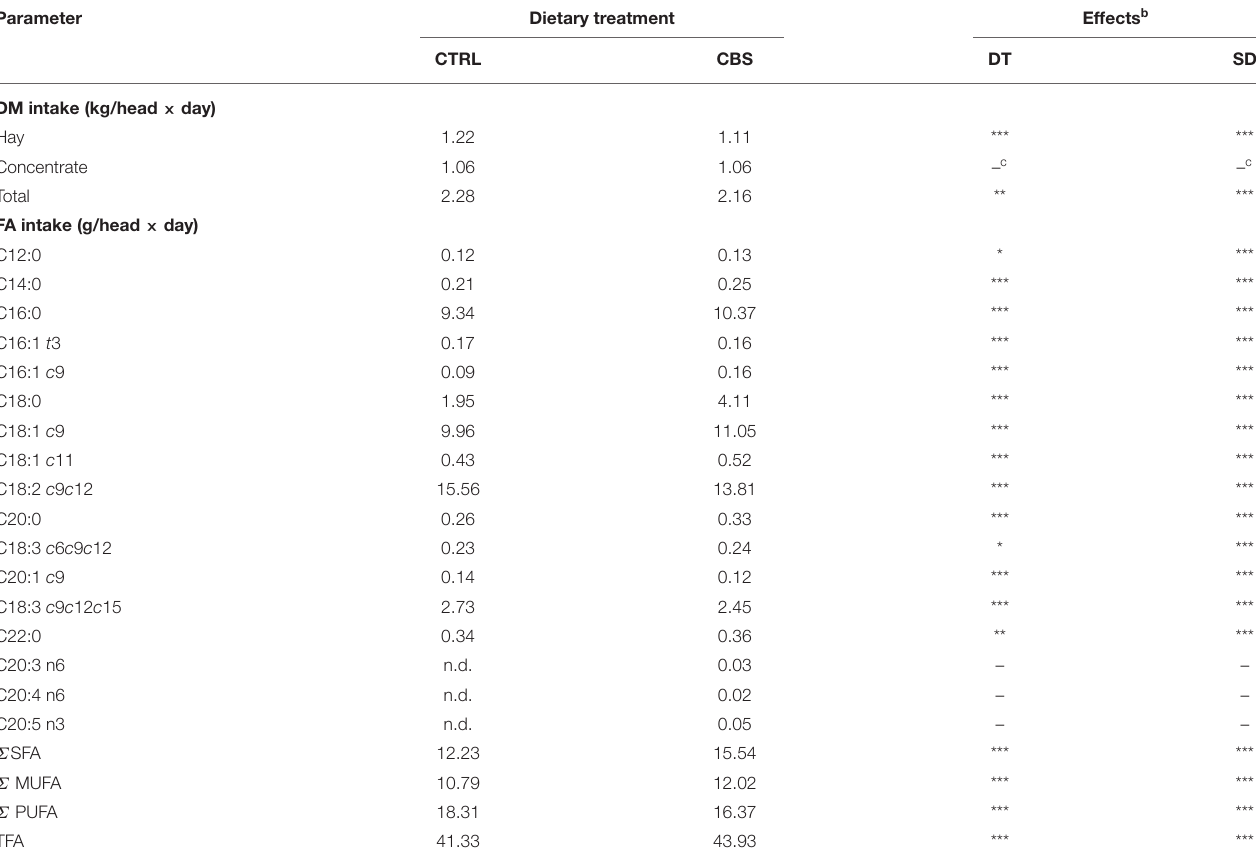
TABLE 2 | Dry matter and main fatty acids intakes of goats fed the control (CTRL) and cocoa bean shell (CBS) diets a . Parameter Dietary treatment Effects b